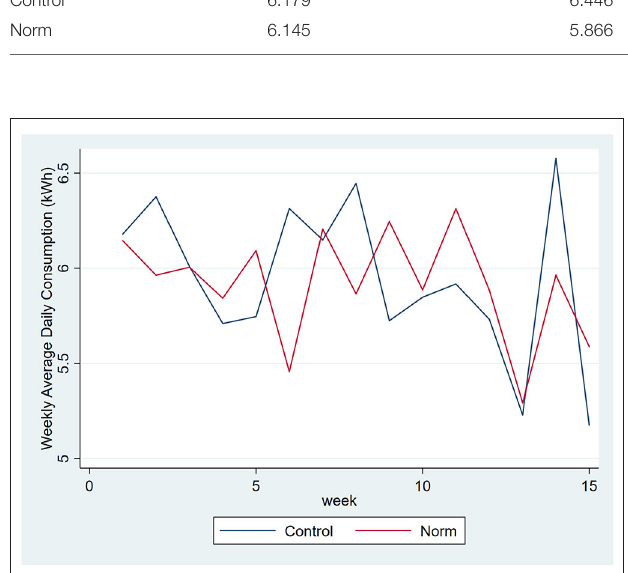
FIGURE 5 | Weekly average daily energy use for households by groups.